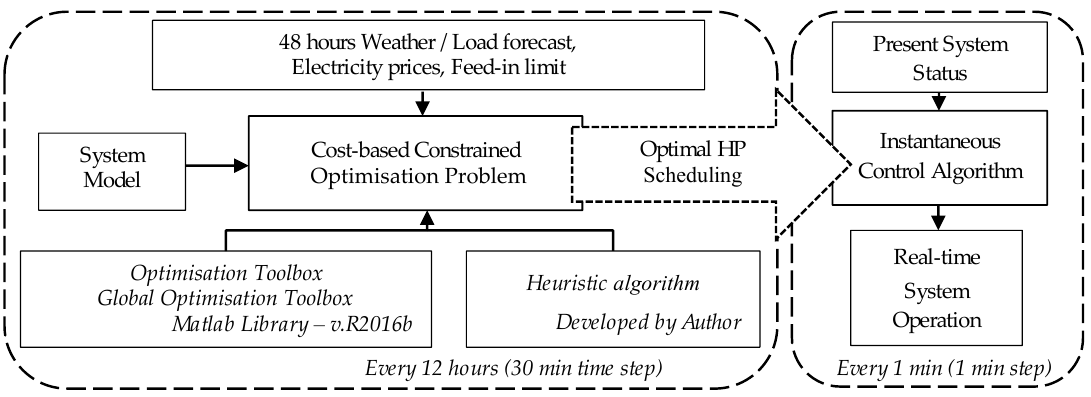
Figure 2. Simplified sketch of the heat pump’s optimal